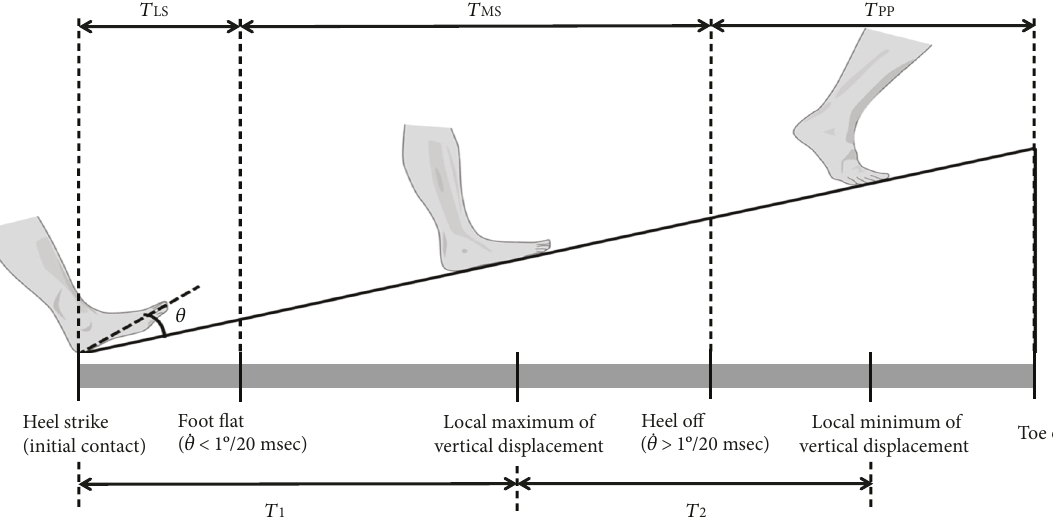
Figure 2: Stance subphases and gait events. The stance phase was divided into three subphases: the loading response (from initial contact to foot fl at, T LS ), the midstance (from foot fl at to heel o ff , T MS ), and the propulsion (from heel o ff to toe o ff , T PP ) phases. T 1 : duration from initial contact to the local maximum of the vertical COM displacement. T 2 : duration from the local maximum of the vertical COM displacement to the local minimum of the vertical COM